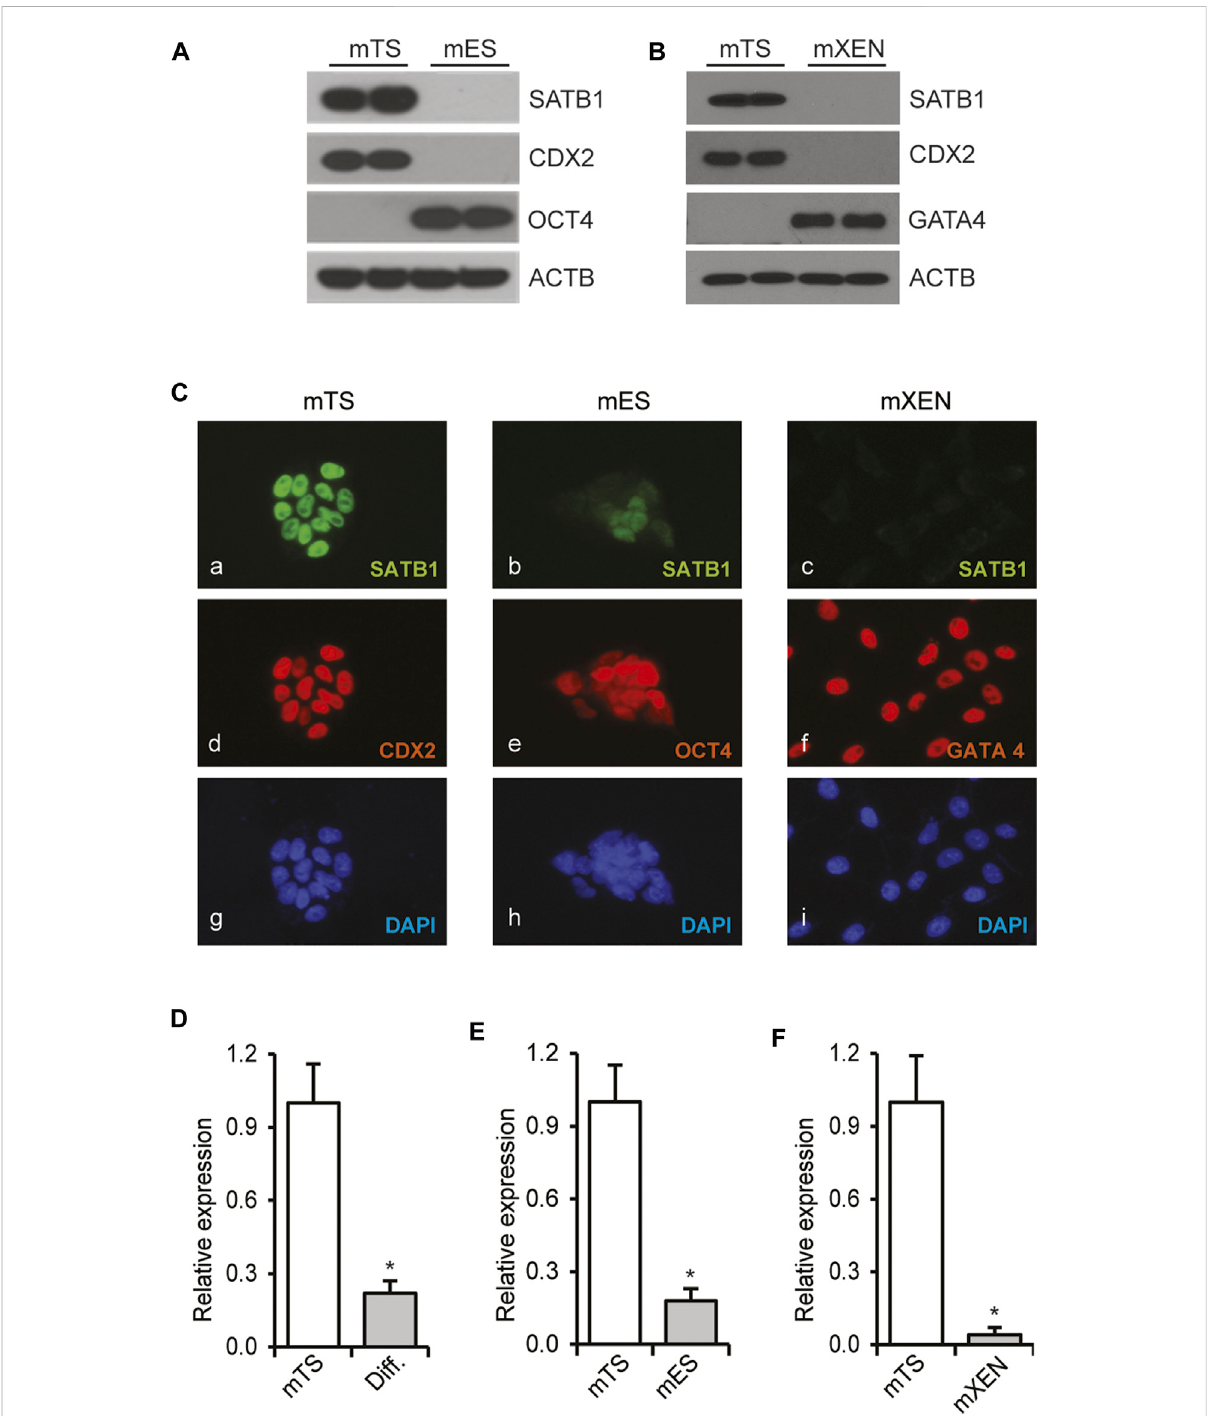
FIGURE 1 Trophoblast-speci fi c expression of Satb1 . Mouse trophoblast stem (mTS) cells express high levels of SATB1 compared to mouse embryonic stem (mES) cells (A) or mouse extraembryonic endoderm (mXEN) cells (B) as detected by western blotting. CDX2, OCT4, and GATA4 were used as lineage markers. ACTB was used as a loading control. Immuno fl uorescence imaging (C) demonstrated abundant expression of SATB1 in mTS cells (Ca). Compared to mTS cells, the level of expression is remarkably lower in mES cells (Cb) and mXEN (Cc). Satb1 mRNA levels in TS, ES and XEN cells (D – F) correlatedwellwithproteinexpression (A – C) ,andinmTScells,themRNAlevelsweresigni fi cantlyreduceduponinductionoftrophoblast differentiation (D) . RT-qPCR data are expressed as mean ± S.D. *, p < 0.05 ( n = 3). Diff. Differentiated mTS